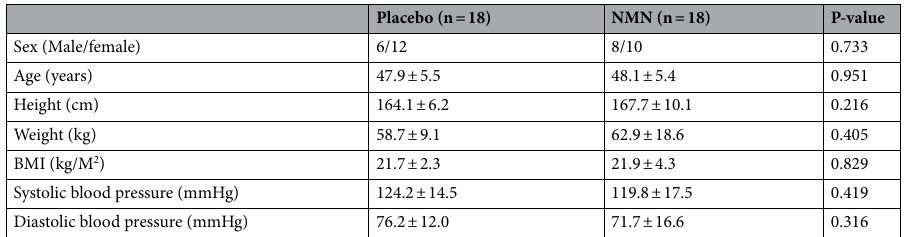
Table 1. Baseline characteristics of study participants. Values are presented as mean ± standard deviation. Each parameter was measured prior to the initiation of the intervention. To analyze any significant differences between groups, data on sex were assessed by the chi-square test, and other parameters such as age, weight, BMI, and blood pressure were tested using Welch’s t test. Statistical significance was set at p < 0.05. BMI body mass index, NMN nicotinamide